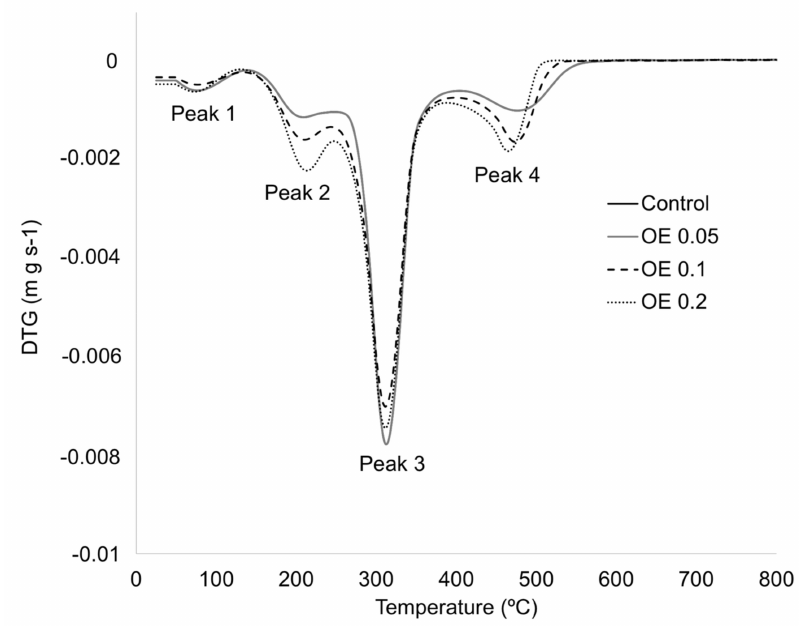
Figure 7. Derivative thermogravimetric (DTG) curves obtained for edible